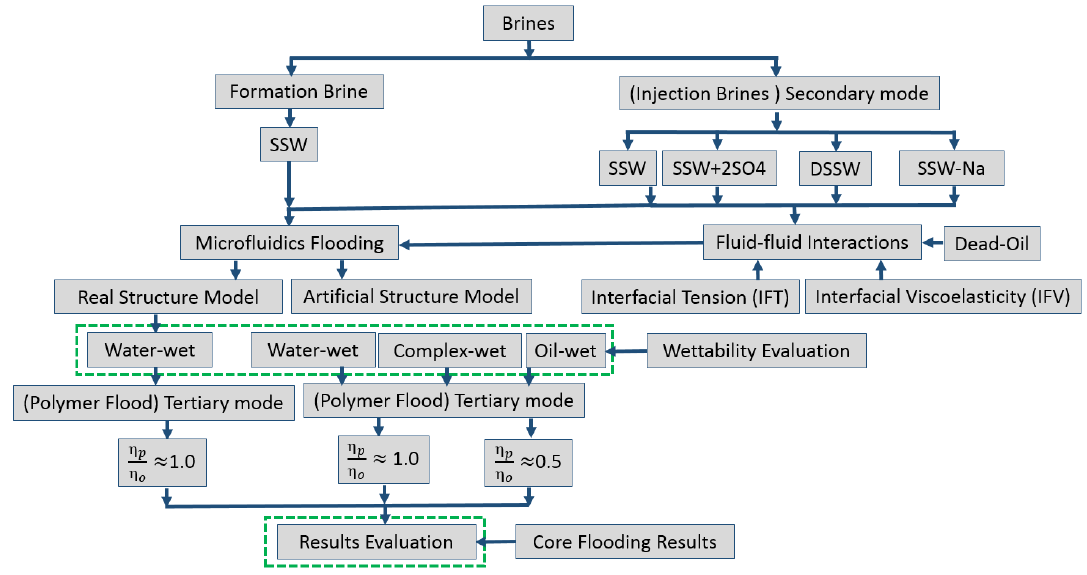
Figure 2. Adopted workflow in the research for the hybrid enhanced oil recovery (EOR) process evaluation. Brine Preparation and Optimization: Four di ff erent injection brines were prepared to correlate and cross-validate the fluid–fluid interaction and oil recovery results. The amount of sulfate in the brine and TDS were the key parameters for